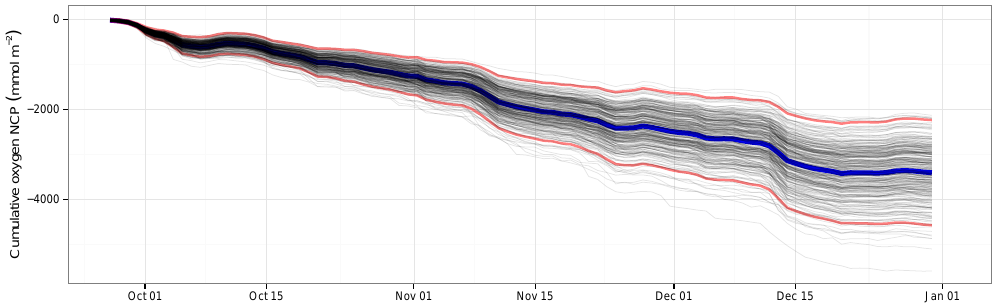
Figure 5. Warp 2008 winter cumulative NCP. Mean value shown in blue. Red lines indicate 95% confidence limits. Black lines correspond to each simulation